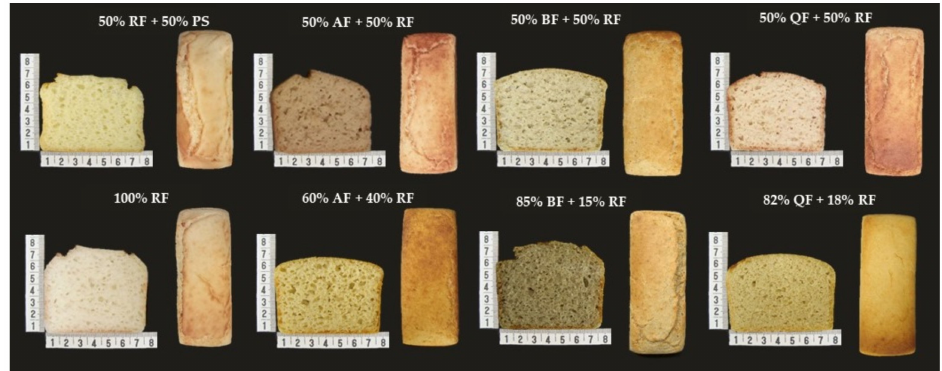
Figure 4. Photographs of central slices and crust of the selected gluten-free bread formulations according to the levels of AF—amaranth flour; BF—buckwheat flour; QF—quinoa flour; RF—rice flour; PS—potato